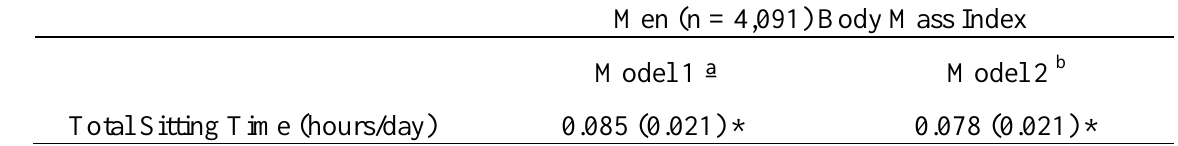
Table 3. Linear regression analysis (Unstandardized Coefficients and Std. Error) predicting Body Mass